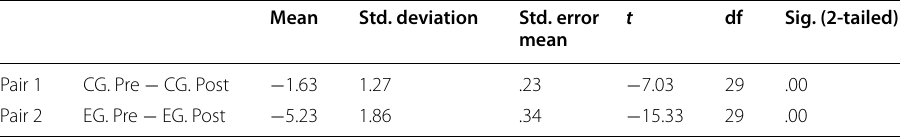
Table 16 Anxiety pretest descriptive statistics Group